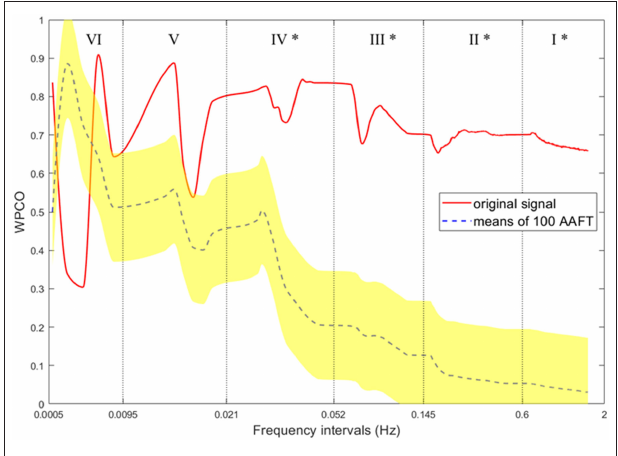
FIGURE 5 | Wavelet phase coherence. Original (red) and Alternative (blue) signals, subject #12, channel #01, channel